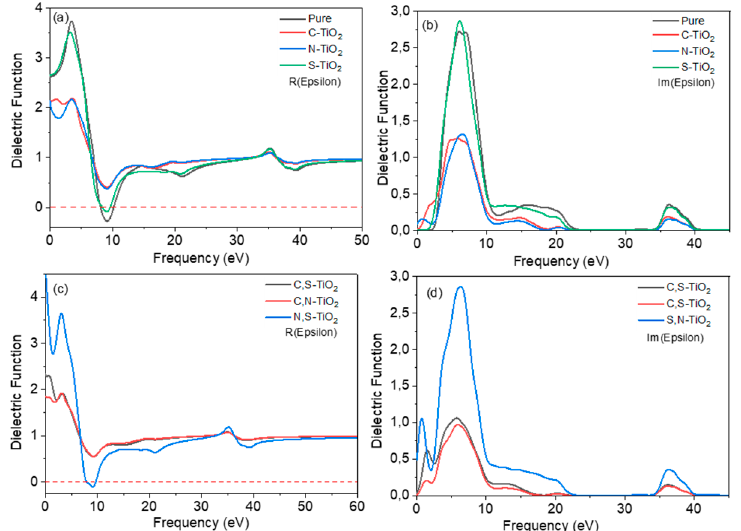
Figure 5. Real parts of the dielectric function of ( a ) pure, (C, N and S) mono-doped and ( b ) (C-N, N-S and S-N) co-doped and imaginary parts of the dielectric function of ( c ) pure, (C, N and S) mono-doped, and ( d ) (C-N, N-S and S-N) co-doped.